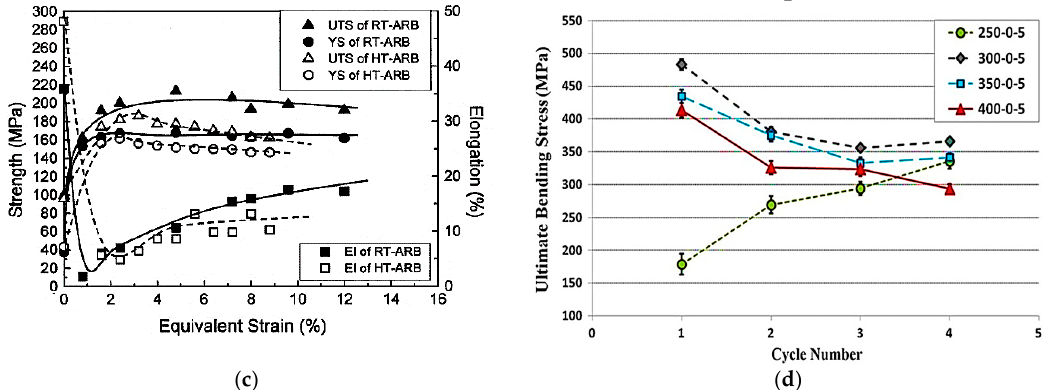
Figure 5. ( a ) Variation in diffusion layer width with rolling temperature for ARBed Al/Ti sheets [45], ( b ) Influence of both rolling temperature and roll speed on bond toughness of Al strips [42], ( c ) Variation of ambient tensile properties of 8011 alloy with increasing the equivalent strain in RT-ARB and HT-ARB samples [46], ( d ) Ultimate bending strength of the ARBed Al/AZ31 at different temperatures [47].